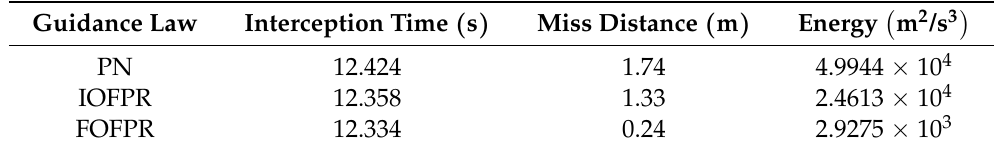
Table 5. Analysis of the bang-bang maneuver